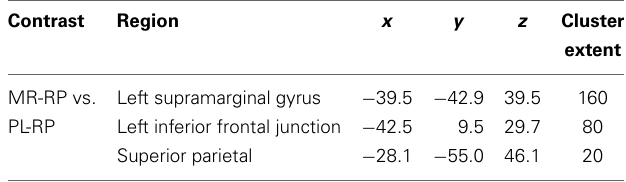
Table 4 | Brain regions that showed conjunction effects of decreasing univariate activity and classification